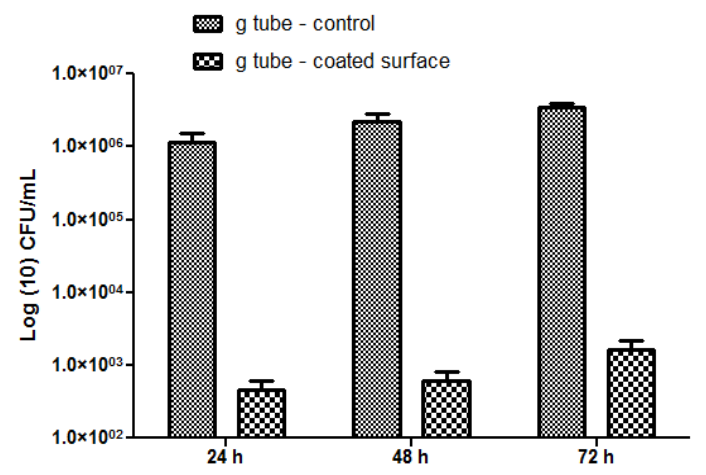
Figure 10. S. aureus biofilms formation on ordinary (bare) and bioactive nanoparticle modified G-tubes for 24, 48 and 72 h of incubation at 37 °C.